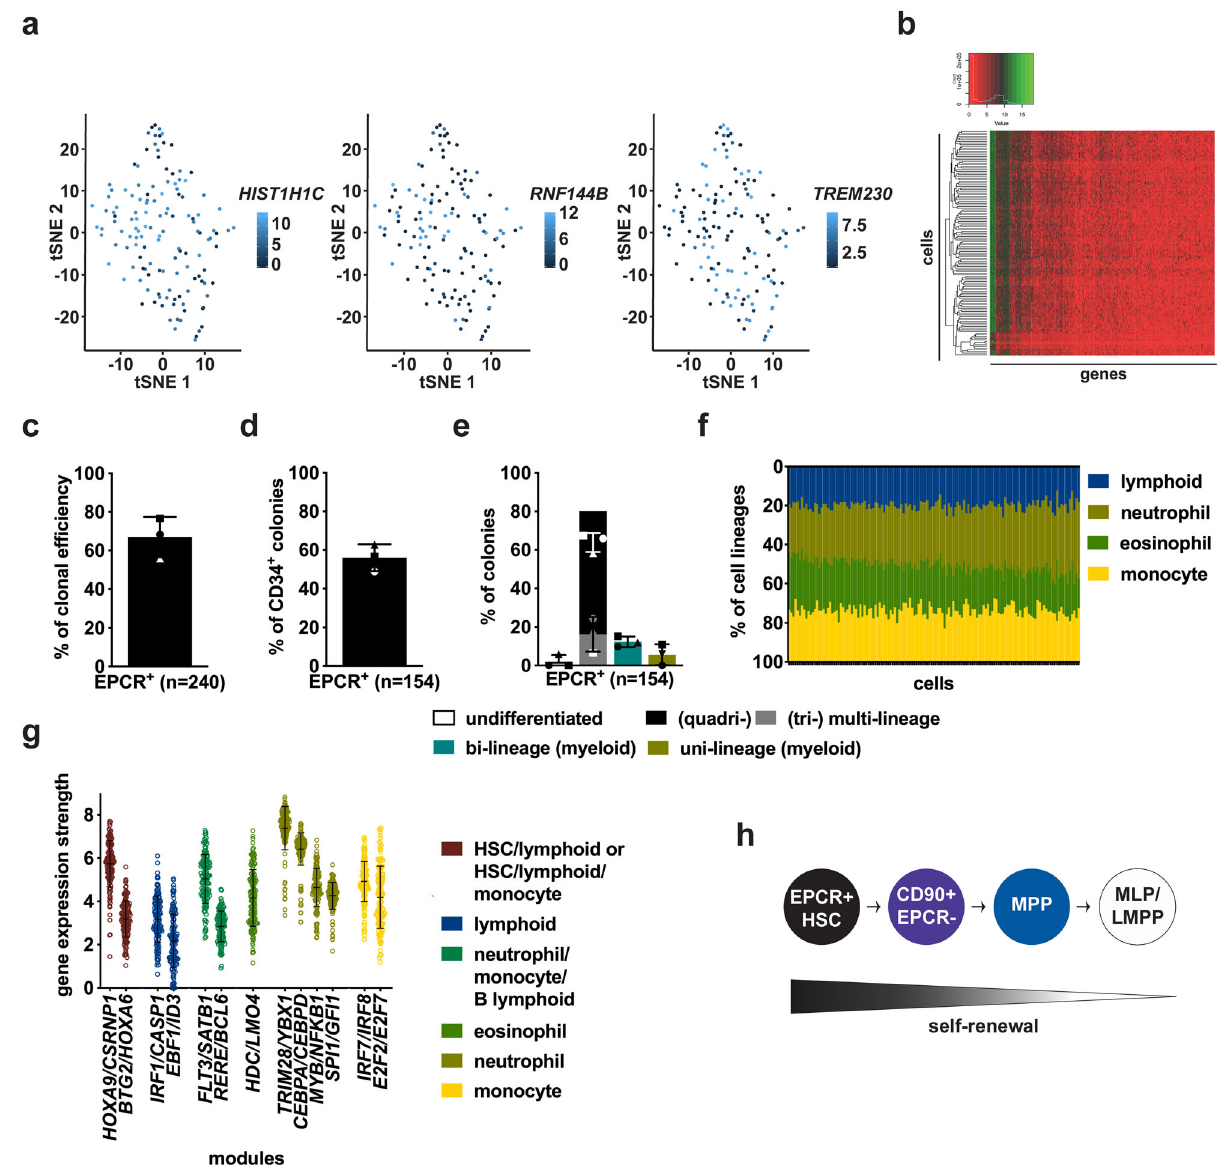
Fig. 7 Single cell transcriptomic and functional studies show that EPCR + is a quasi-homogenous HSC population. a Representative t-SNE-based plots of 135 single EPCR + HSCs based on the most variable genes determined in Supplementary Fig. 6. b Hierarchical clustering of 135 single EPCR + HSCs. c Clonal ef fi ciency of 240 single EPCR + cell cultures (from three independent experiments). d Percentage of colonies containing CD34 + HSPCs derived from single EPCR + HSCs ( n = 154 colonies from three independent experiments). e Percentage of colonies of the indicated type derived from single EPCR + HSCs ( n = 154). f Distribution of the overall gene expression in 135 single EPCR + HSCs associated with the denoted cell lineages based on the lineage-priming modules used 8 . g Expression strength of the genes associated with the denoted lineage-priming modules detected in the single EPCR + HSCs ( n = 135). h Schematic representation of the new hierarchical organization within the most primitive CD34 + compartment supported by all the data presented in this study. Bars and lines are the mean values and error bars are the S.D for the no. of experiments or single cells performed. Source data are provided as a Source Data fi